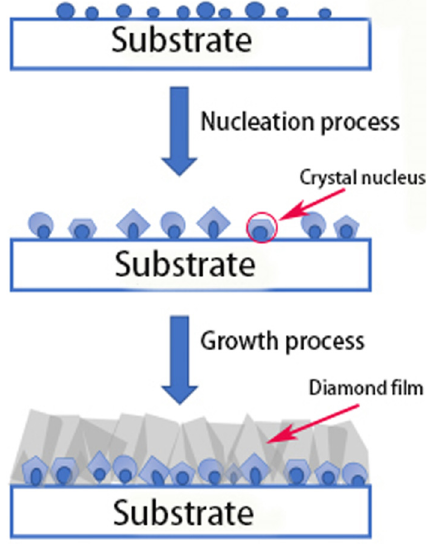
Figure 1: Schematic diagram of diamond grain growth.